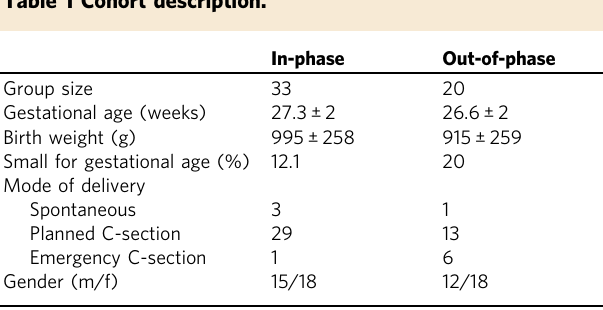
In total, 53 5-year-old preterm infants from Lübeck, Cologne and Essen were included in the in- phase and out-of-phase groups (i.e., 54 out of n = 107 children fell into a nondescript middle group). Data describing both groups are expressed as means ± SD. No statistical differences were found between the groups when analyzed by two-sided Mann – Whitney test for confounder variables such as birth weight, gestational age, small for gestational age and gender. Notehoweverthe potentially confoundingassociationof modeof